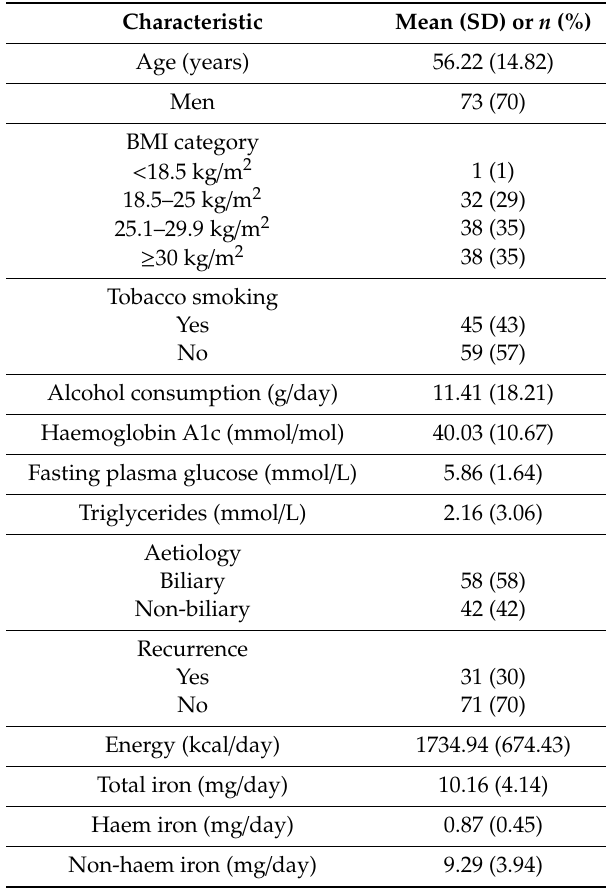
Table 1. Characteristics of the study